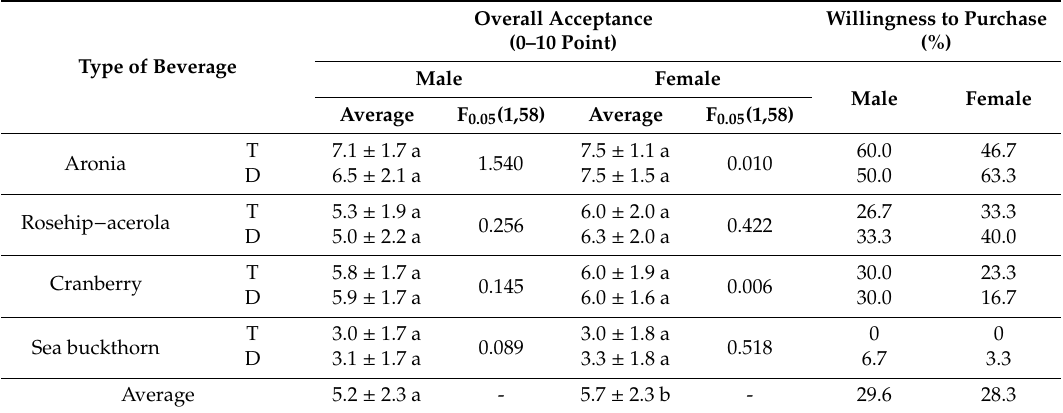
Table 5. Consumer acceptance and willingness to purchase fruit-herbal beverages depending on